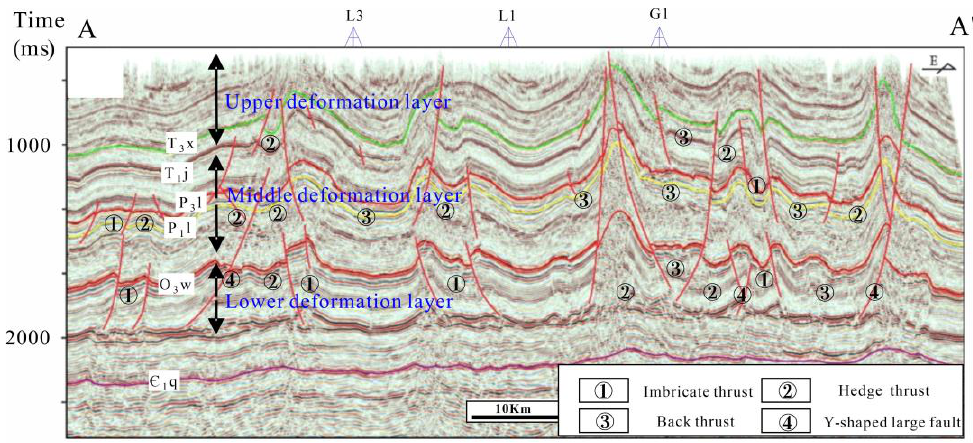
Figure 3. The interpretation section of the structural style in the Luzhou area (see Figure 1 AA ’